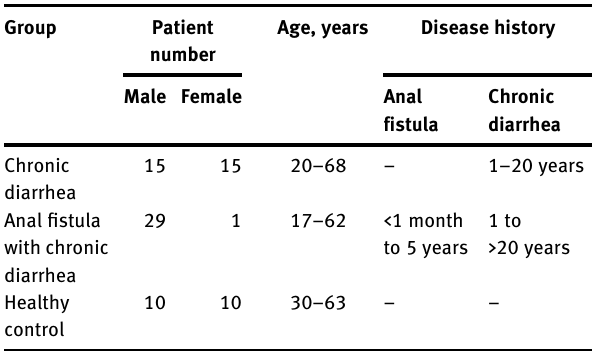
Table  : The demographic parameters of anal fi stula, chronic diar- rhea and healthy control